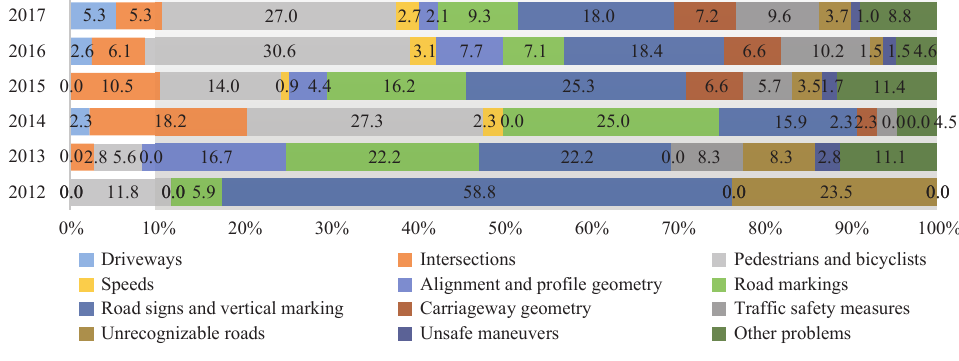
Figure 8. The occurrence frequency of each problem category for streets and local